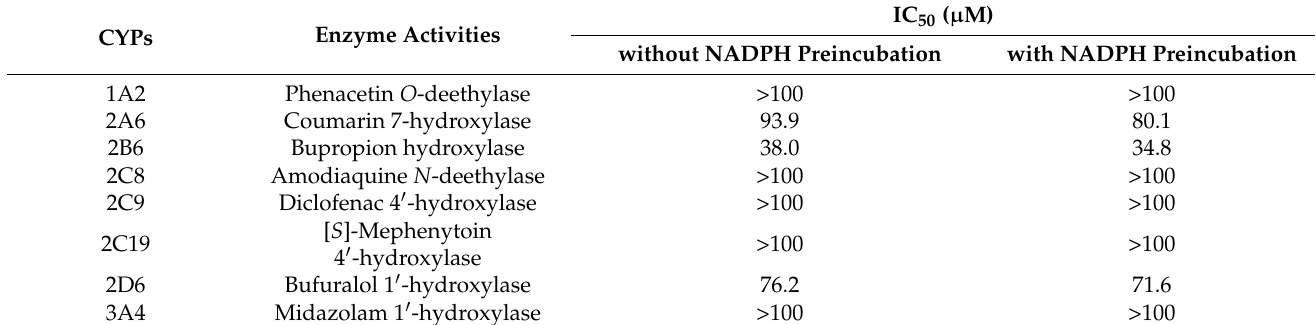
Table 5. Inhibition of eight major CYP enzyme activities by β -amanitin with and without a 30 min preincubation in the presence of NADPH in ultrapooled human liver microsomes.